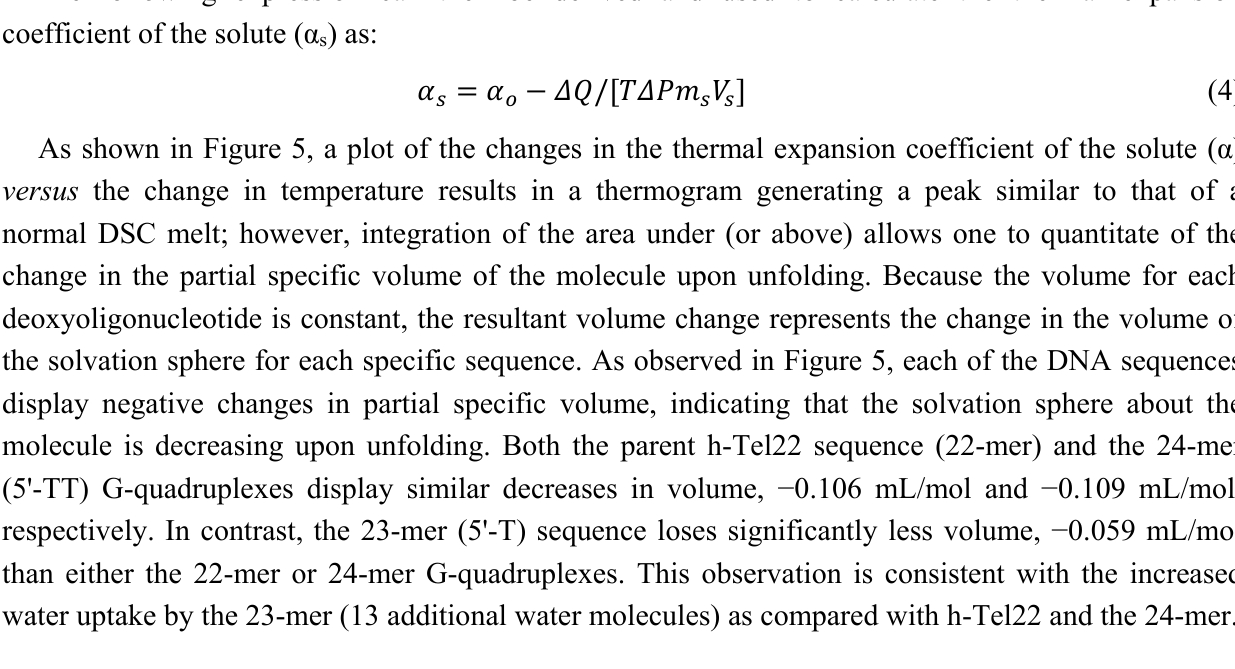
parent h-Tel22 ( 5'-AGGG(TTAGGG) and the 24-mer ( 5'-TTAGGG(TTAGGG) provided by Microcal (GE Healthcare). Water/water, water/buffer and buffer/buffer scans